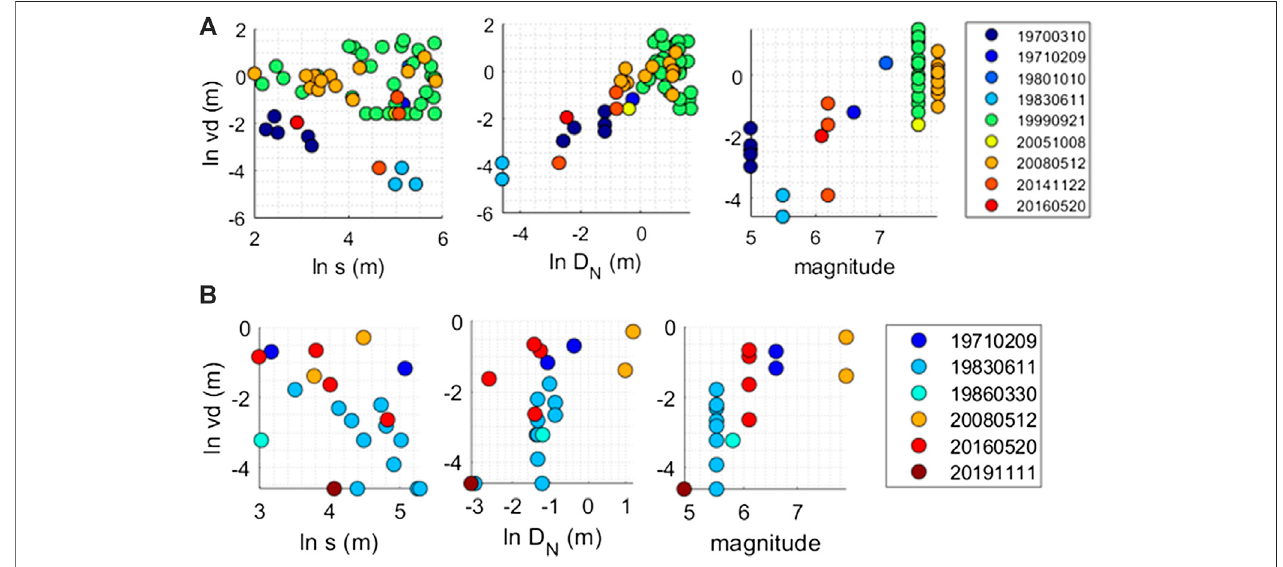
FIGURE 10 | Relationship between vertical displacement ln ( vd ) and i) distance from the PF, ln ( s ), ii) ln D N , and iii) magnitude, M w for (A) hanging wall and (B) footwall.